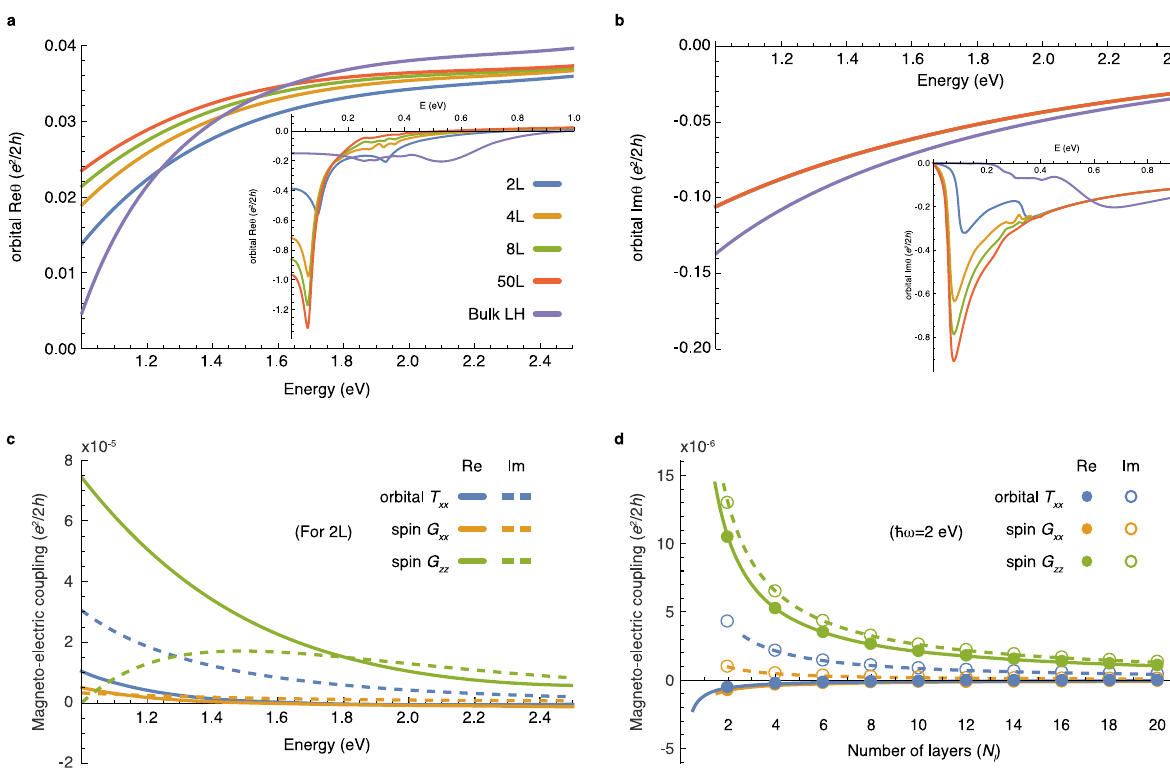
Fig. 4 | Optical magneto-electric coupling in the low-energy tight-binding model of MnBi 2 Te 4 . a and b Real and imaginary part of the orbital magneto- electricaxionangle.BulkLHindicatestheopticallayerHallconductivitycalculated with periodic boundary conditions. Bulk LH approaches the exact axion magneto- electric coupling as photon energy increases. Orbital magneto-electric T xx and the spin magneto-electric coupling. Spin parts contribute to axion angle and T xx